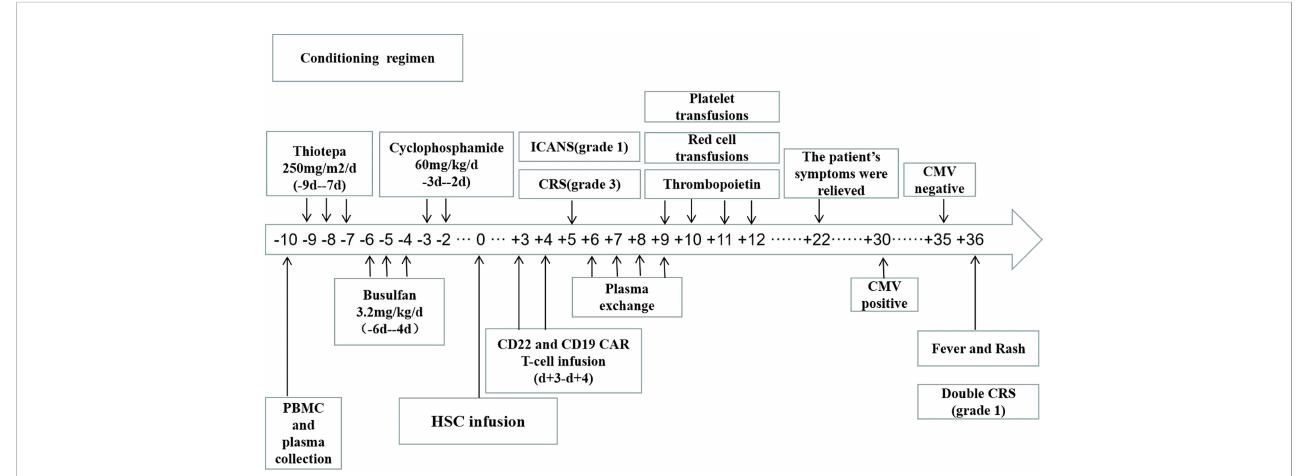
FIGURE 2 The patient underwent peripheral blood mononuclear cell and plasma collection on d-10 and received conditioning regimen before HSC infusion on do. Two separate CAR T-cell products (CD22 and CD19 CAR T-cells) were infused within the range of 3-4 days (d+3 to d+4) after HSC infusion.